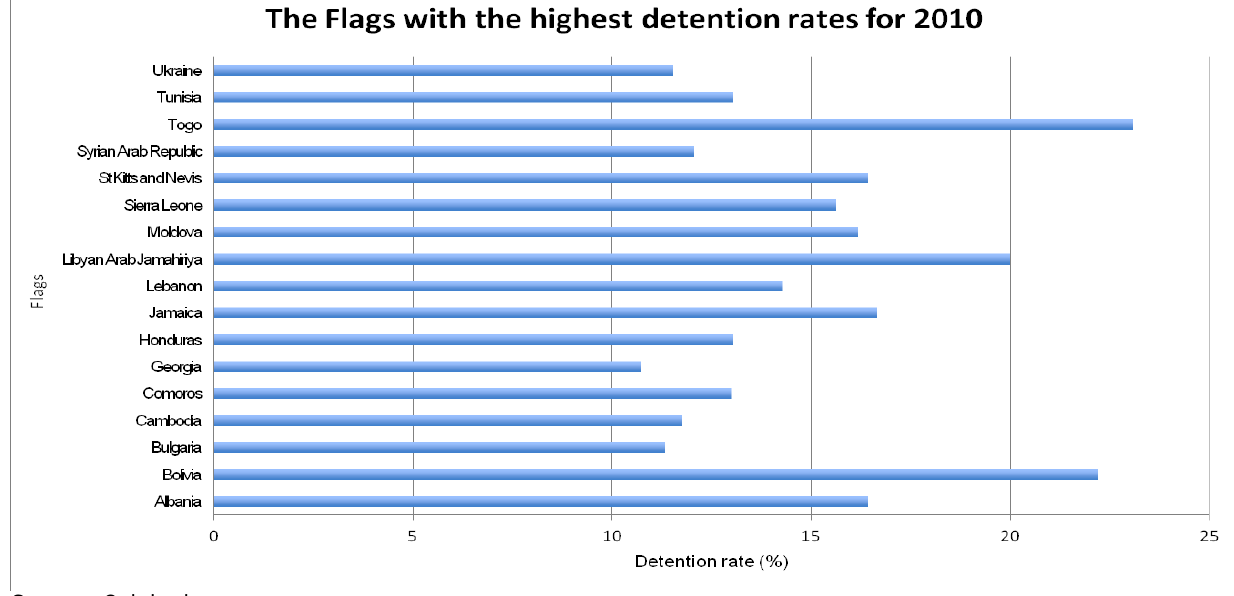
Source: Original